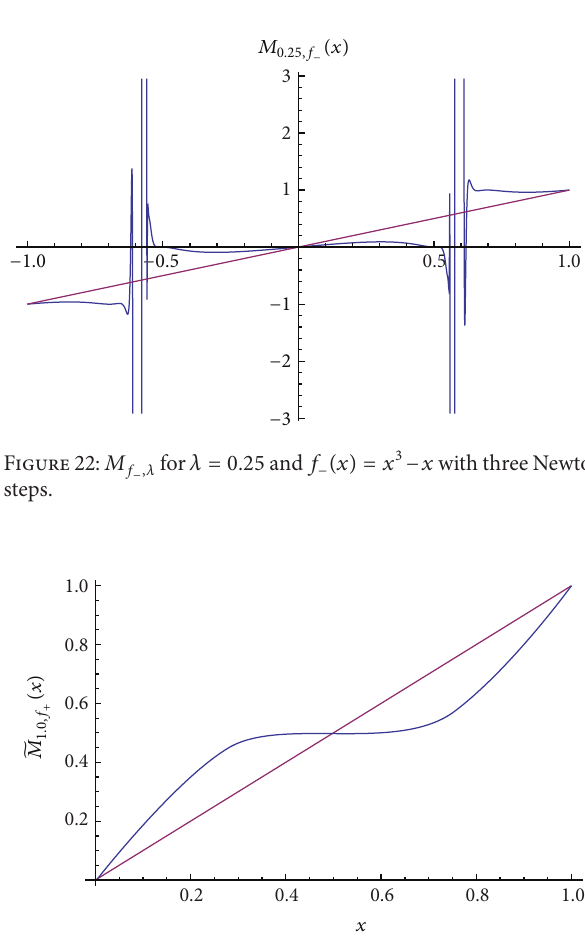
(𝑥) = 𝑥 3 + 𝑥 with three Newton +